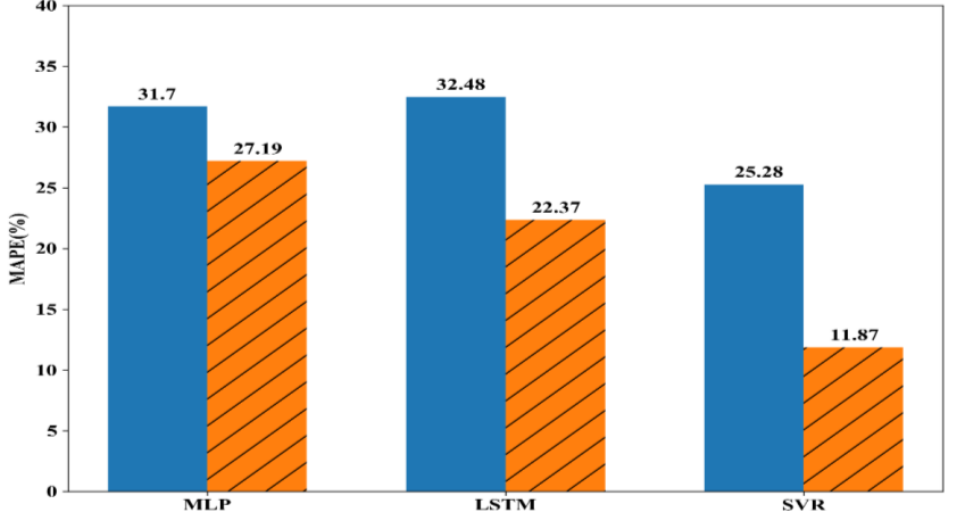
Figure 6. Experiment result for battery #1.